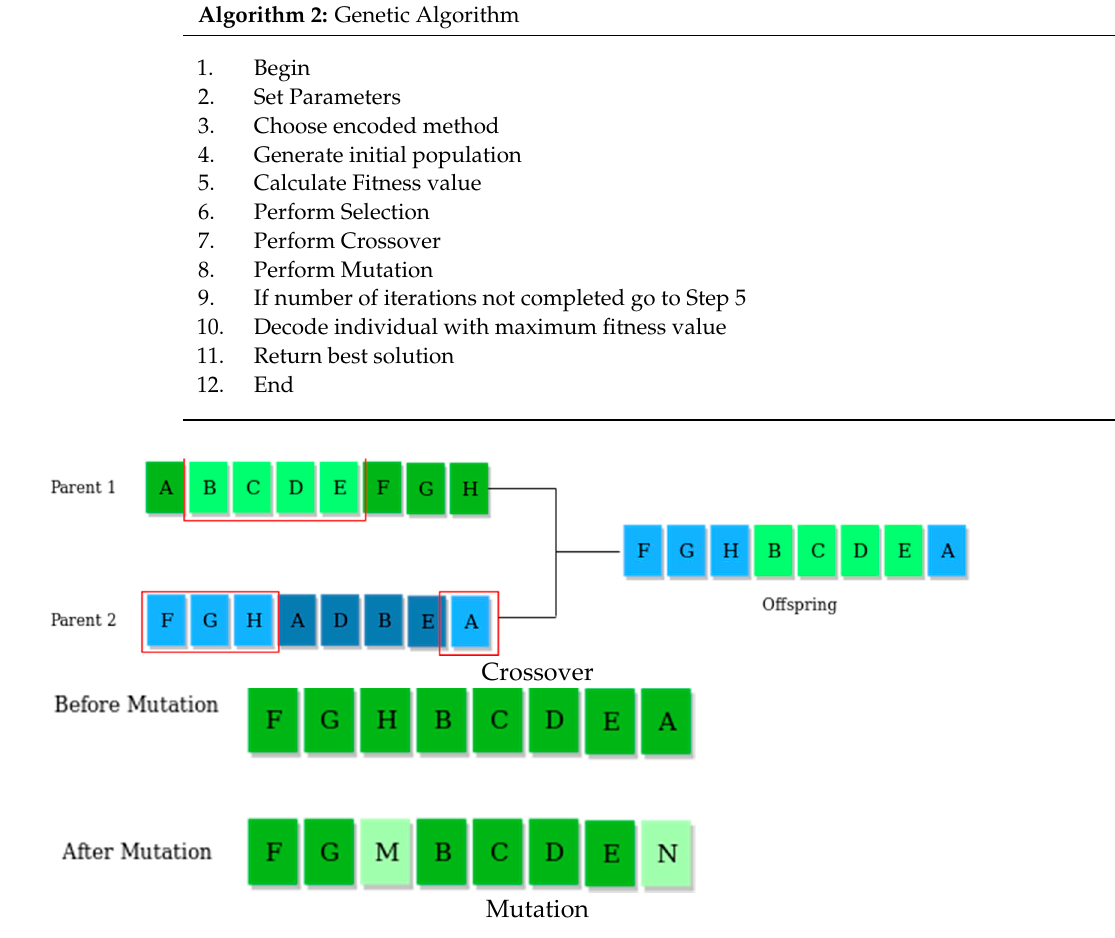
Figure 4. GA crossover and mutation procedure.